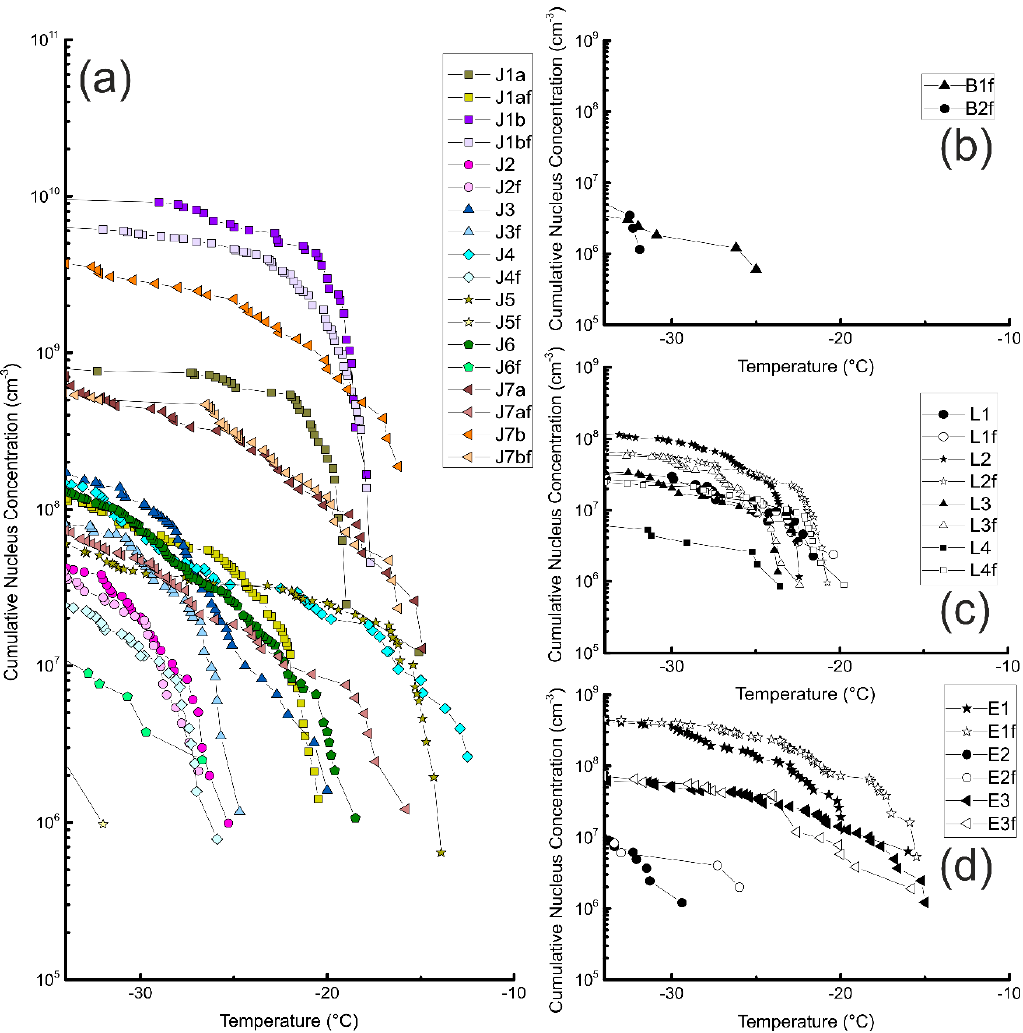
Figure 3. ( a ) K(T photo ) of the analyzed samples. Juices (black currant (J1a,b), blueberry (J2), chokeberry (J3), cranberry (J4), lingonberry (J5), sambuccus (J6) sea buckthorn (J7a,b)); ( b ) extracts of leaves (blueberry (L1), juniper (L2), raspberry (L3), and sea buckthorn (L4)); ( c ) extracts of leaves (blueberry (L1), juniper (L2), raspberry (L3), and sea buckthorn (L4)); ( d ) extracts of dried berries (juniper berries (E1), rowanberries (E2), sea buckthorn (E3)). Samples marked with an f are filtered and do not contain particles bigger 0.2 µm. Data points at temperatures below − 35 °C are not represented, since we cannot exclude homogeneous nucleation events at lower temperatures and therefore cannot attribute those data points to INM with full certainty.